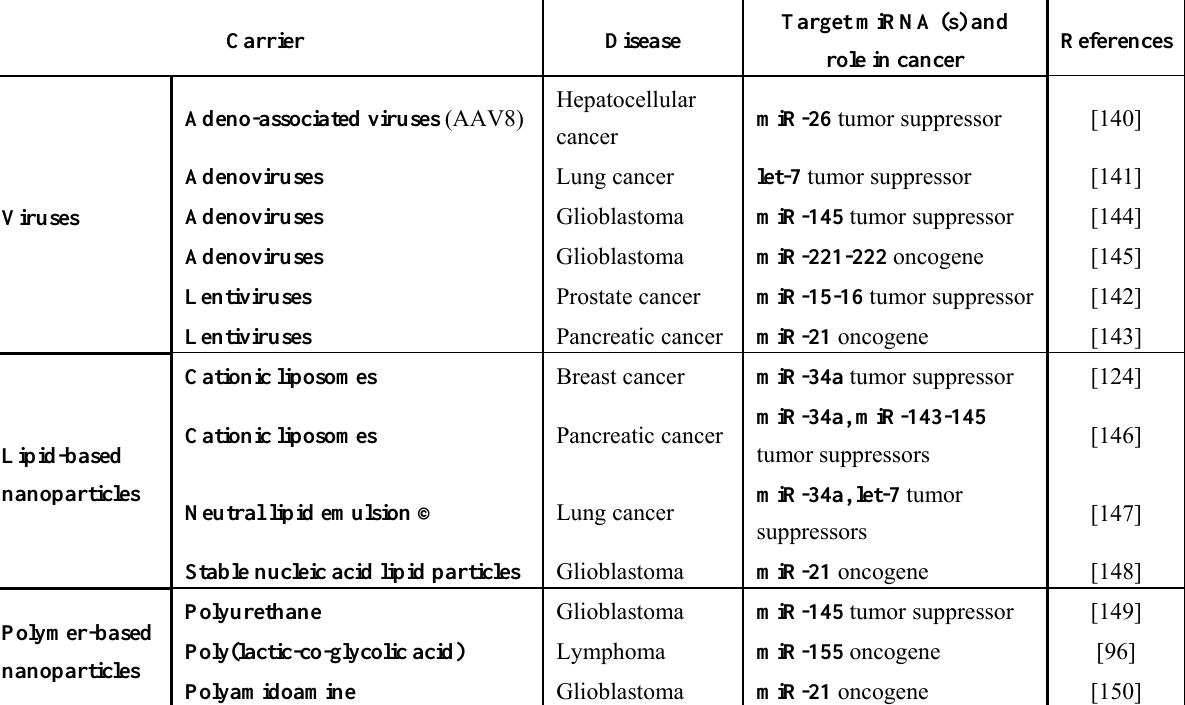
Table 1. MiRNAs as targets for cancer therapy through delivery of anti-miRNA oligonucleotides or miRNA-expressing constructs mediated by viral and non-viral vectors. Target miRNA (s) and Carrier Disease role in